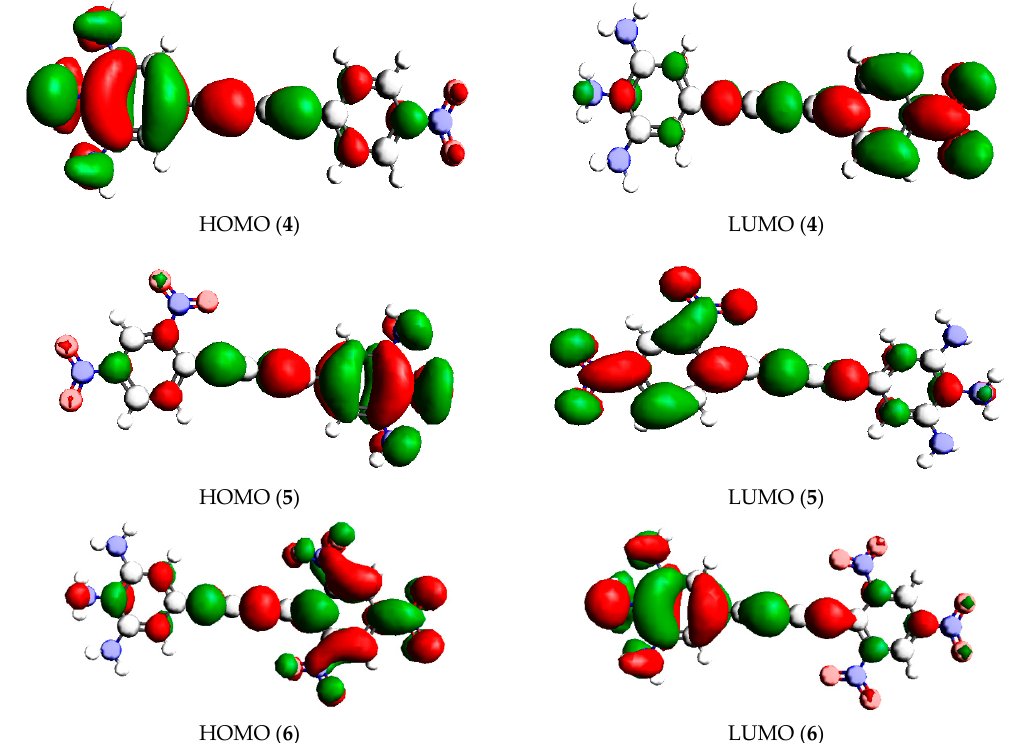
Figure 2. HOMOs and LUMOs of the studied compounds( R and 1 − 6 ).